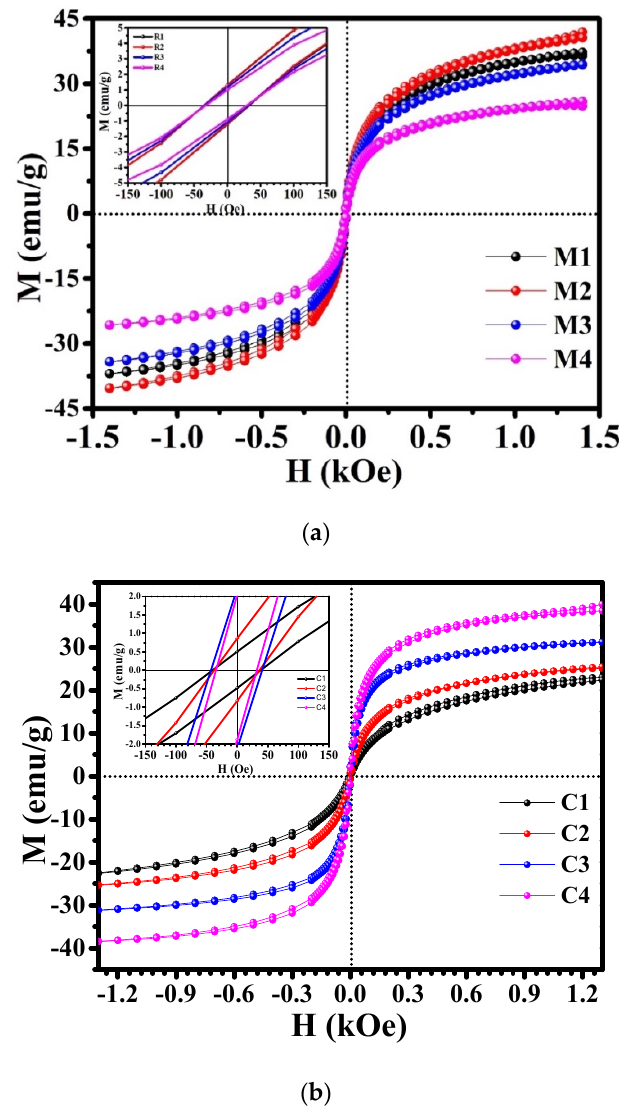
Figure 6. ( a ) M − H curve of samples M1 to M4. ( b ) M − H curve of samples C1 to C4.